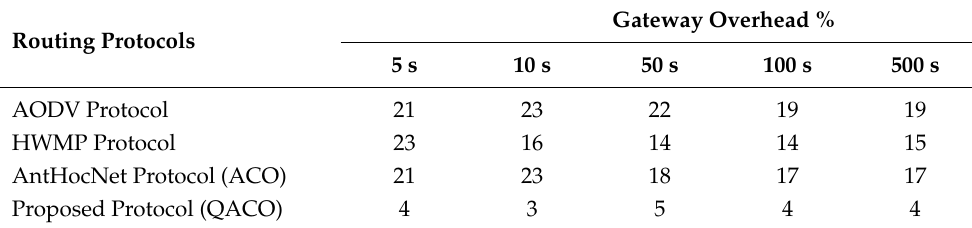
Table 7. GW overhead over simulation running time.